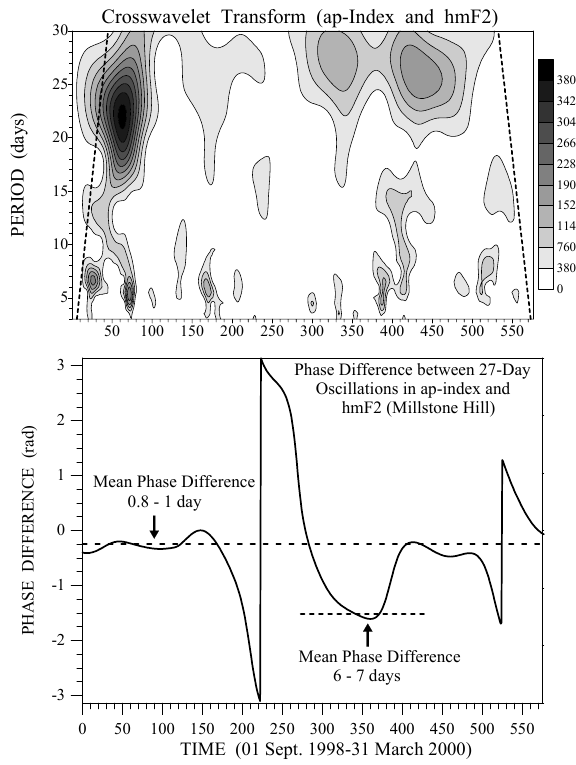
Fig. 5. The same as Fig. 5, but between the geomagnetic A p -index and hm